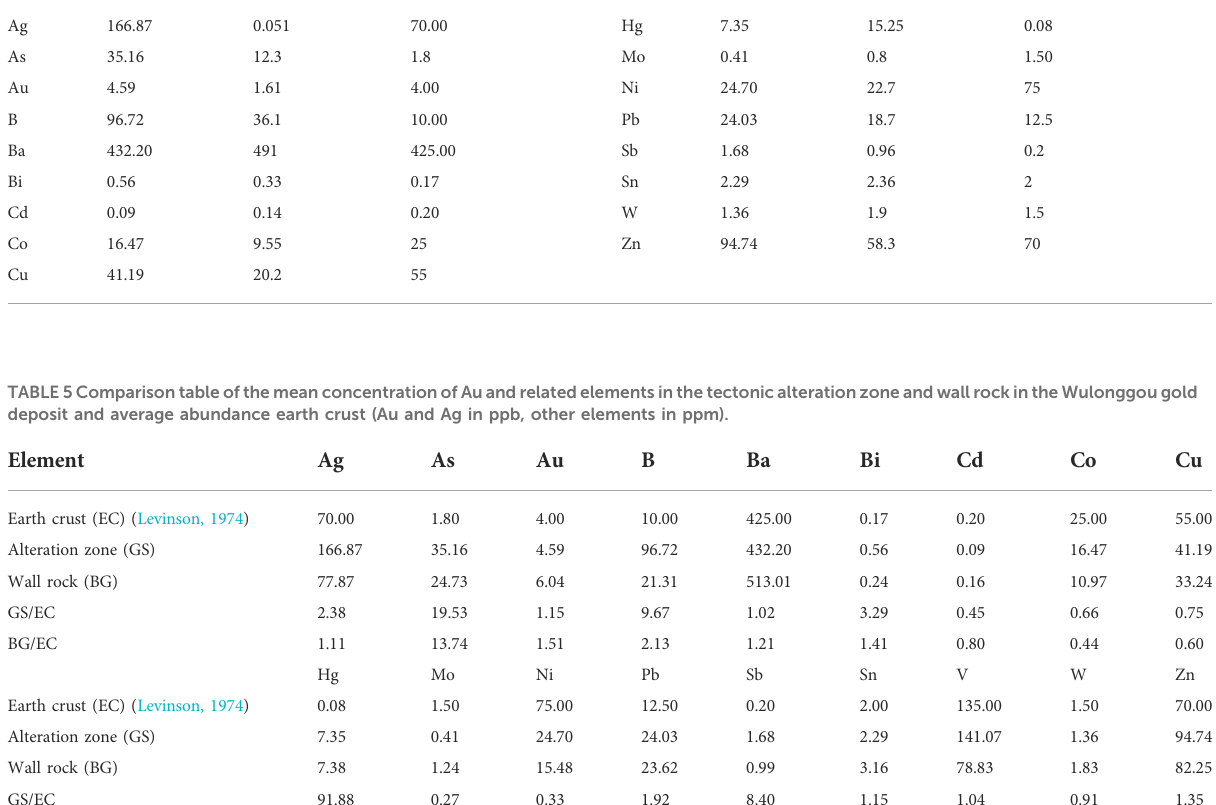
TABLE 4 Average contents of Au and path fi nder elements in the Hongqigou tectonic zone samples. Element Alteration